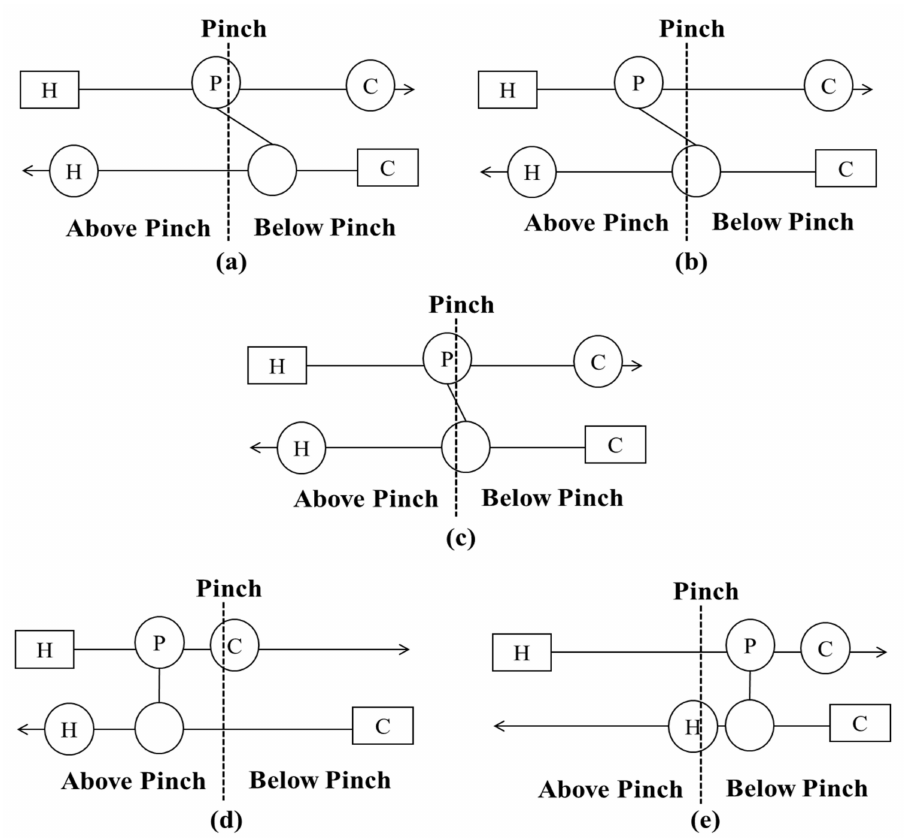
Figure 4. Five different scenarios with cross-pinch heat